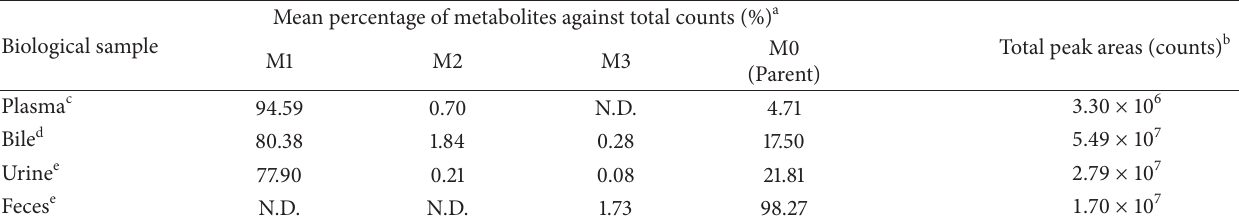
Table 1: The metabolic profile of leonurine in various rat biological samples.